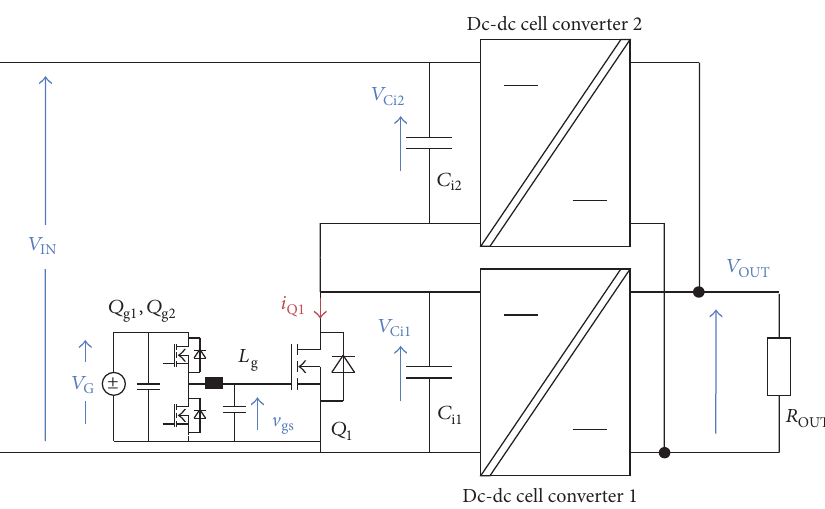
Figure 5: Circuit configuration for experiment of surge current suppression by active gate